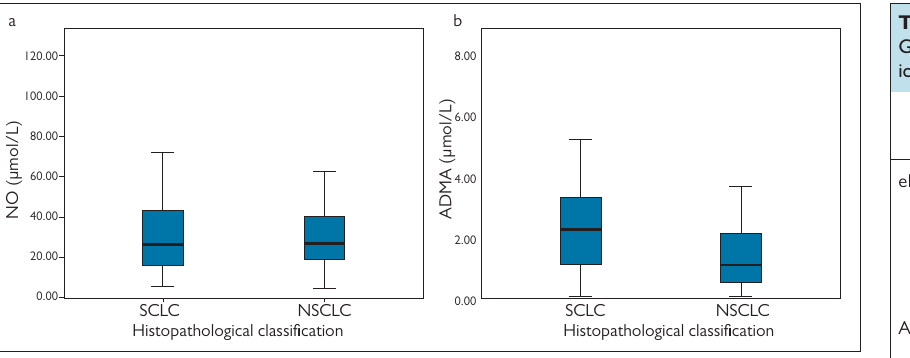
Figure 1. a, b. Distribution of NO (a) and ADMA (b) levels according to histopathological classification